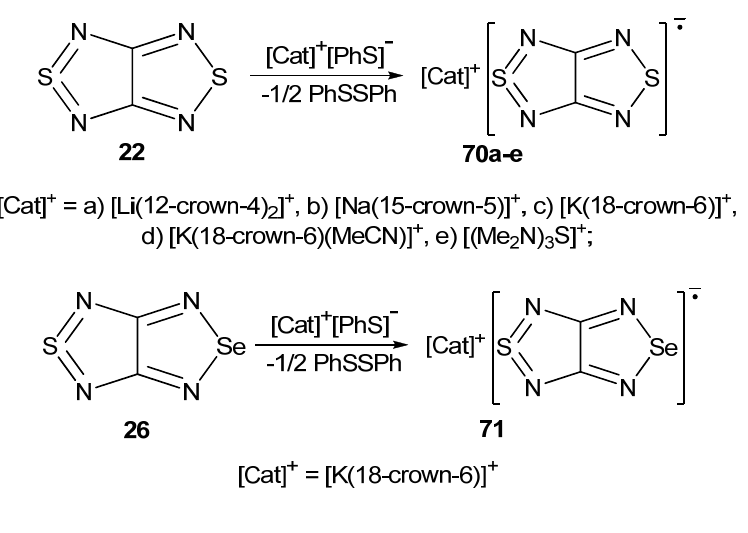
Figure 8. XRD structures of the RA 70a – e and 71 obtained by reduction of heterocycles 22 and 26 with